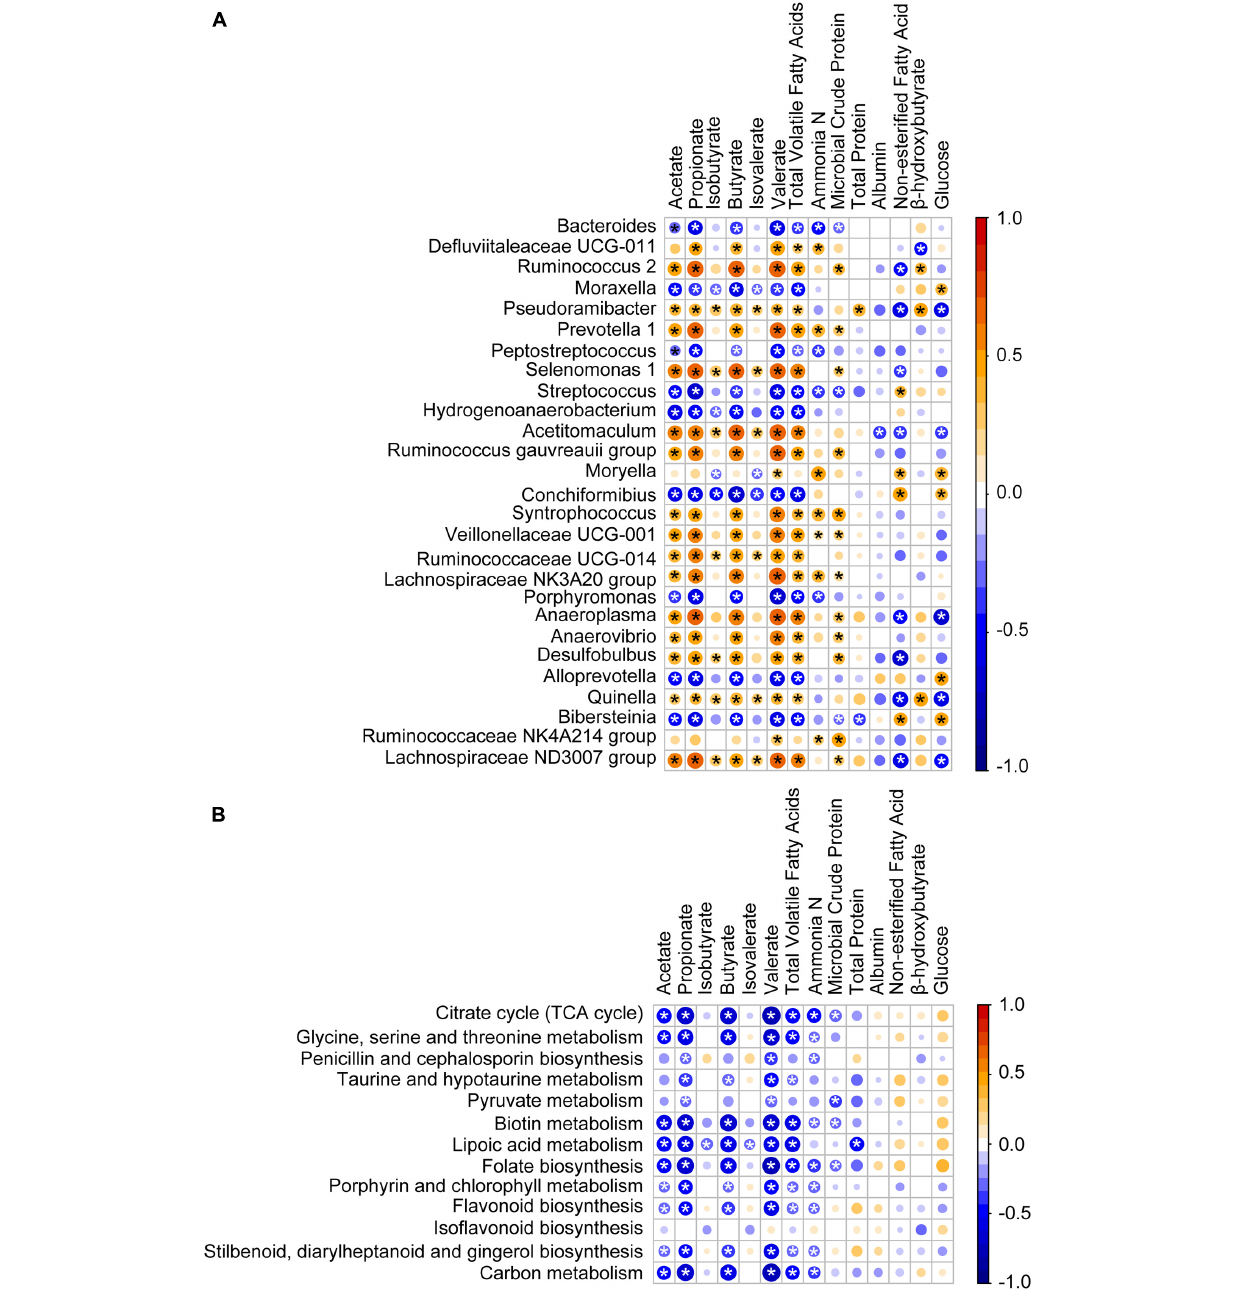
had negative ( P < 0.05) Spearman correlations with